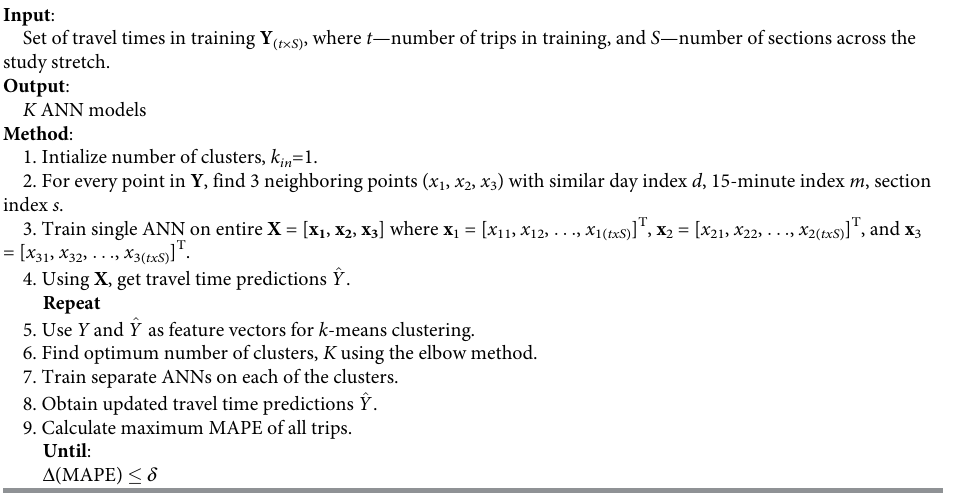
Table 1. Joint clustering and prediction.